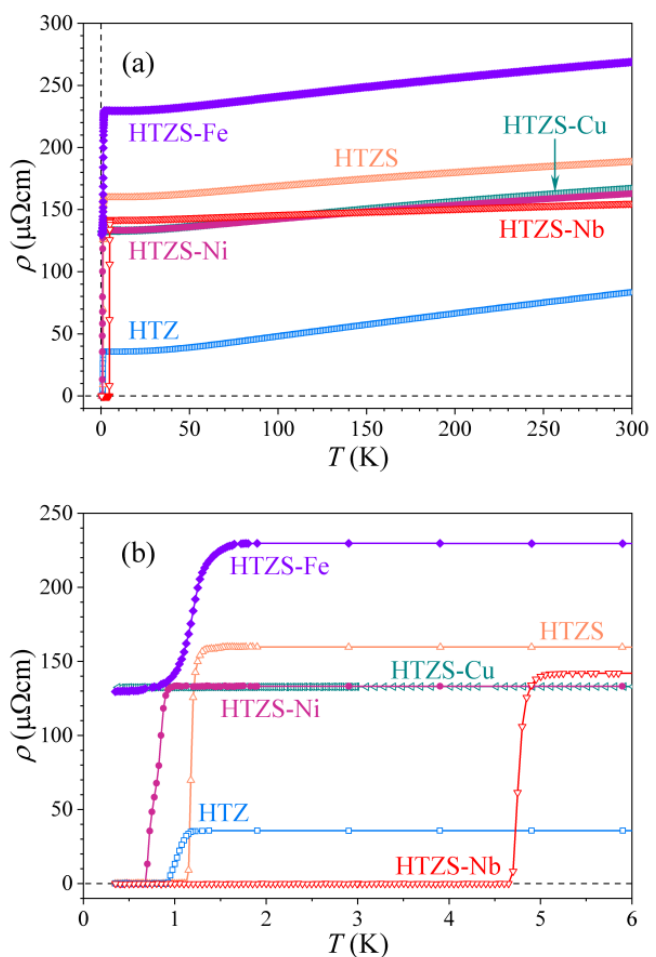
Figure 3. ( a ) Electrical resistivity of the six investigated alloys in the temperature range 300–0.35 K in zero magnetic field. ( b ) The resistivities on an expanded temperature scale below 6 K. Table 4. Parameters determined from the electrical resistivity (the SC transition temperature 𝑇 the 𝜌 300𝐾 resistivity) and the specific heat (the SC transition temperature 𝑇 𝐶 , the upper critical field ( 0 ) , the electronic specific heat coefficient 𝛾 and the Debye temperature 𝜃 𝜇 𝐻 0 𝑐2 gated alloys.